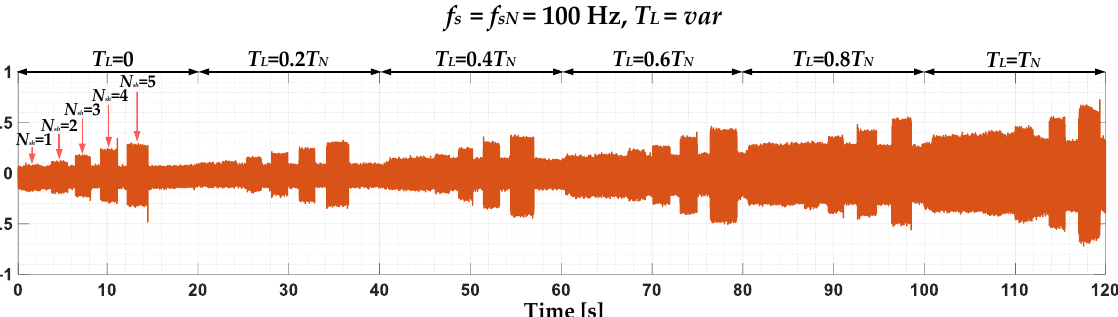
Figure 1. Impact of ITSC in the PMSM stator winding on the waveform of the positive sequence component of the stator phase currents, experimental study ( T L = var, f s = f sN = 100 Hz). The unbalance of the PMSM stator phase currents caused by the ITSC are also visible in the negative sequence component [32]. The waveform of this component for the nominal f s , different T L and N sh is presented in Figure 2. The level of T L has a much smaller impact on the value of the negative sequence amplitude compared to the positive sequence component, and more importantly, a significant increase resulting from the ITSCs is visible. It can also be observed that the higher the N sh , the greater the increase in amplitude.